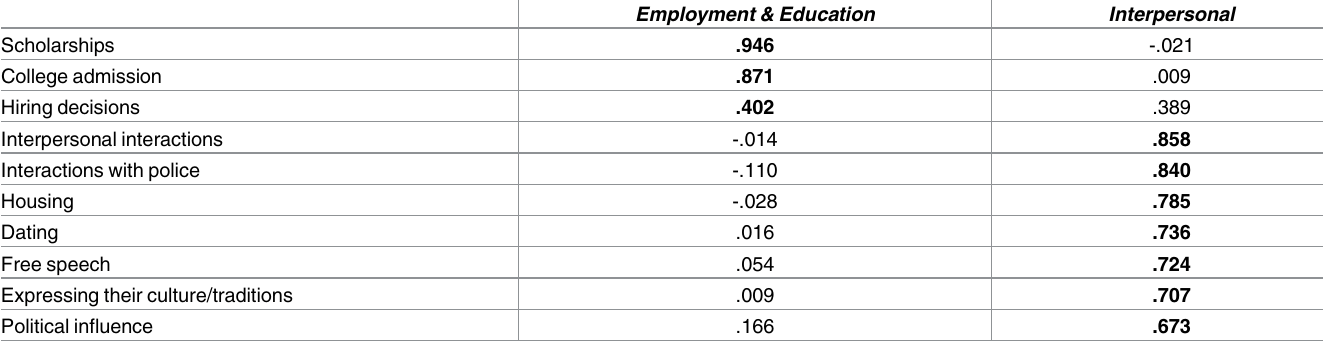
Table 2. Factor loadings (exploratory factor analysis) for domains of anti-White discrimination (Study